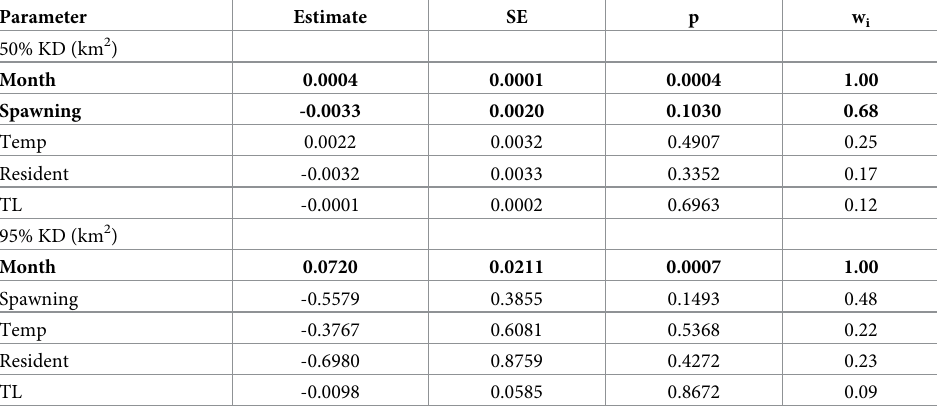
Table 4. Cumulative AIC weights (w), parameter estimates, standard error (SE), and p-values where deltaAIC < 2.